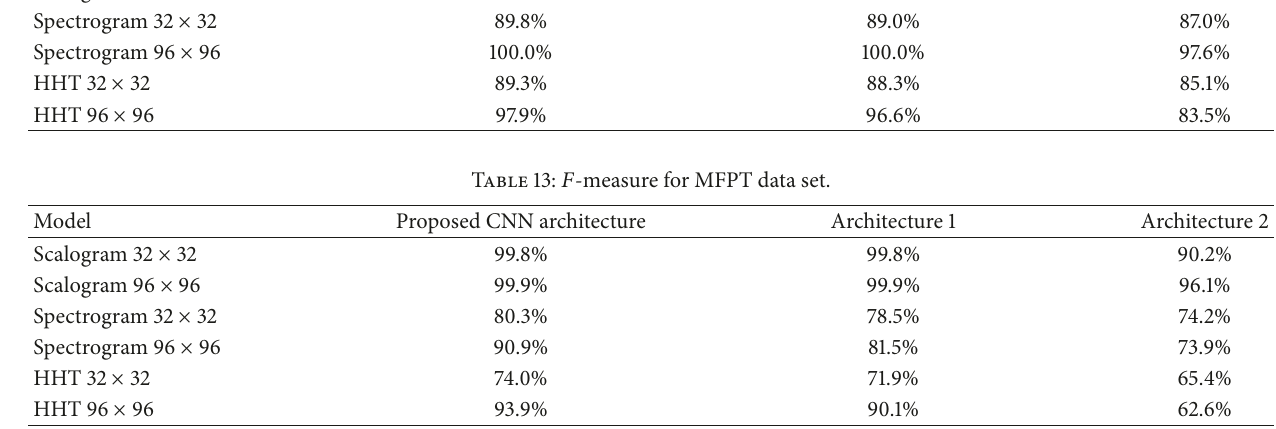
Figure 8. The bearings support the motor shaft. Single